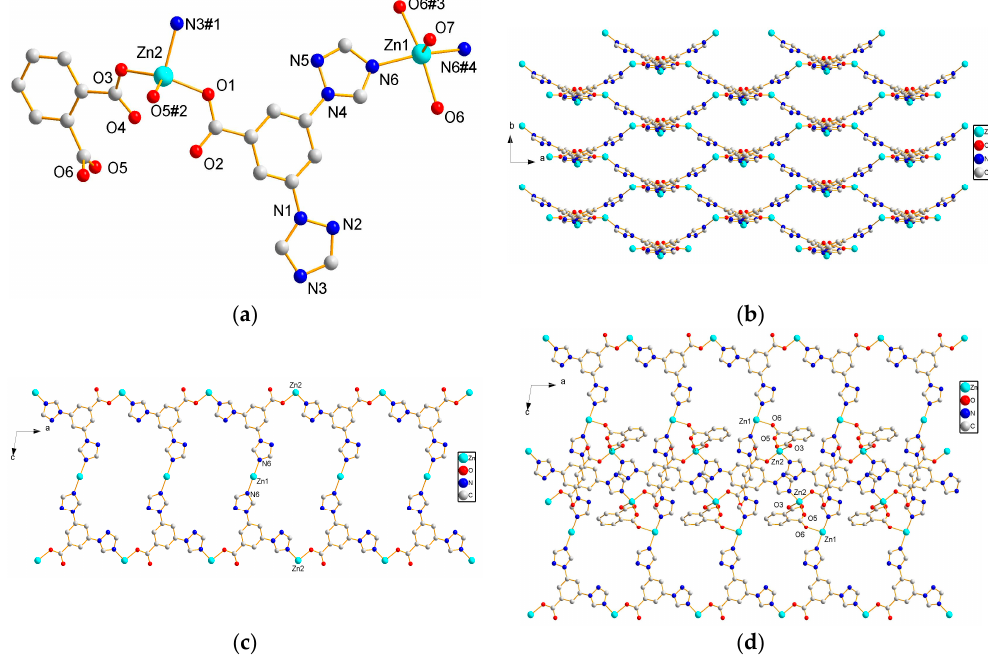
Figure 3. ( a ) Coordination environment of Zn(II) ions in 3 . ( b ) The 2D double layer of 3 in ab plane. ( c ) The 2D double layer of 3 in ac plane. ( d ) The 3D framework of 3 .